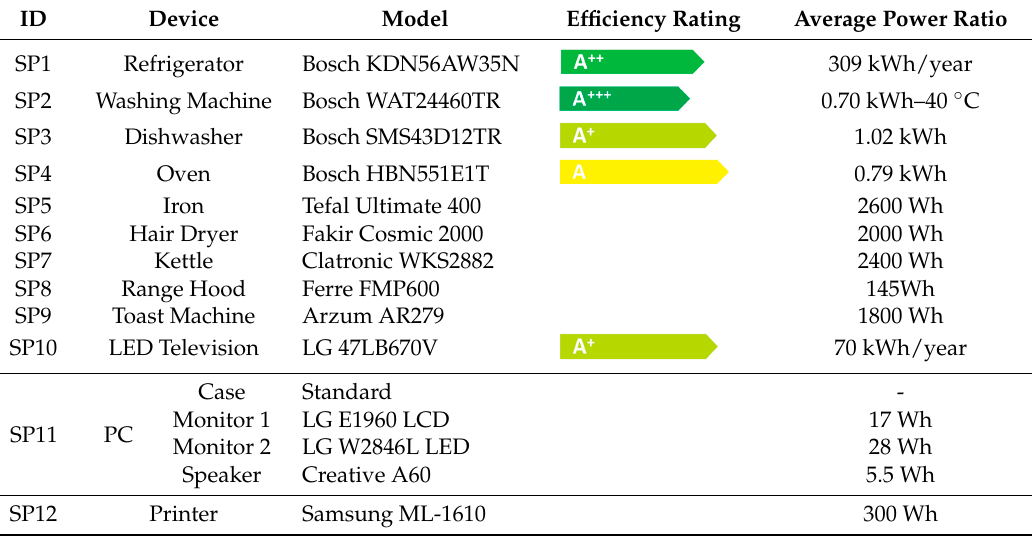
Table 1. The brand, model, efficiency class, and power consumption of the home appliances used in load profile analysis.